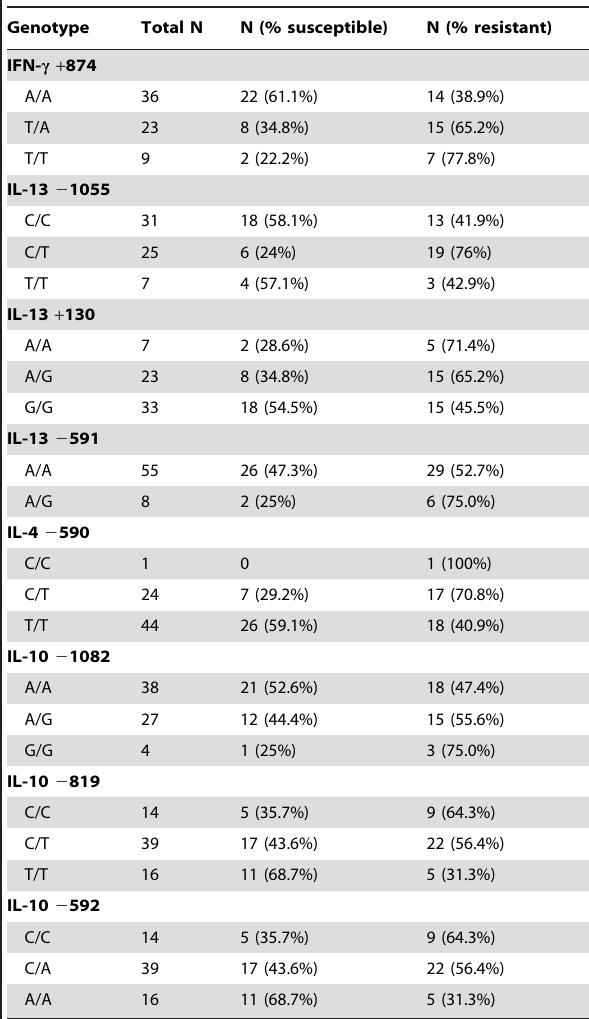
Table 1. IFN- c + 874, IL-13 2 1055, IL-13 + 130, IL-13 2 591, IL-4 2 590, IL-10 2 1082, IL-10 2 819 and IL-10 2 592 genotype distributions and percentage of